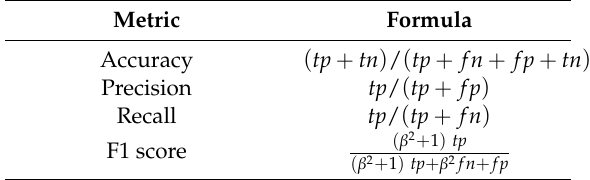
Table 6. Performance metrices for binary classification problem (dataset